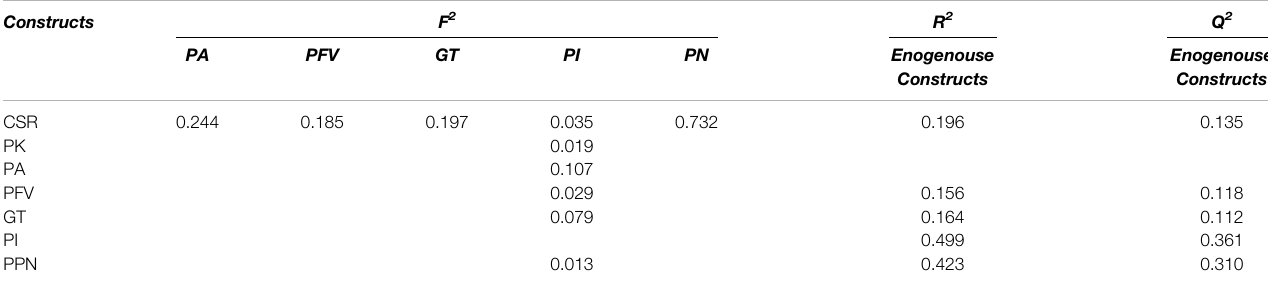
TABLE 4 | Effects size, coef fi cient of determination, blindfolding results. Constructs